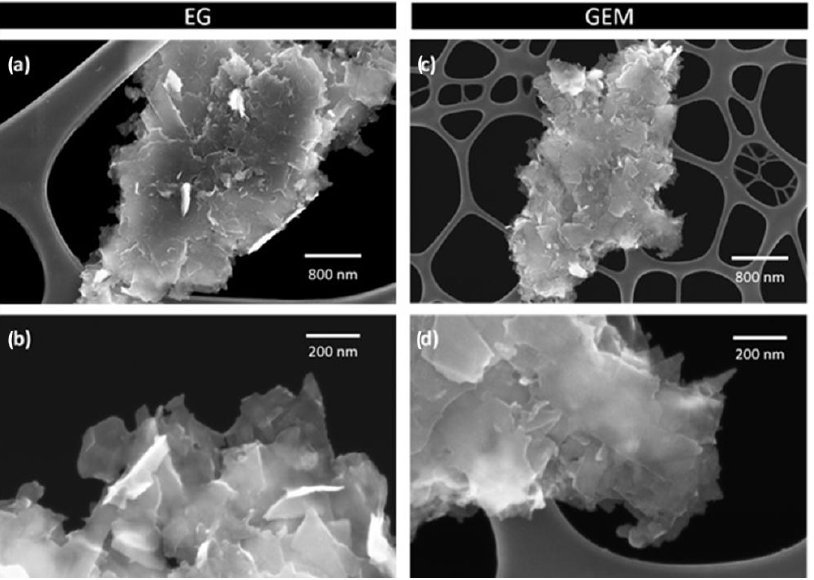
Figure 2. Field-emission scanning electron microscopy images at different magnifications showing exfoliated graphene ( a , b ) and GEM ( c , d ) on lacey carbon membranes. exfoliated graphene ( a , b ) and GEM ( c , d ) on lacey carbon